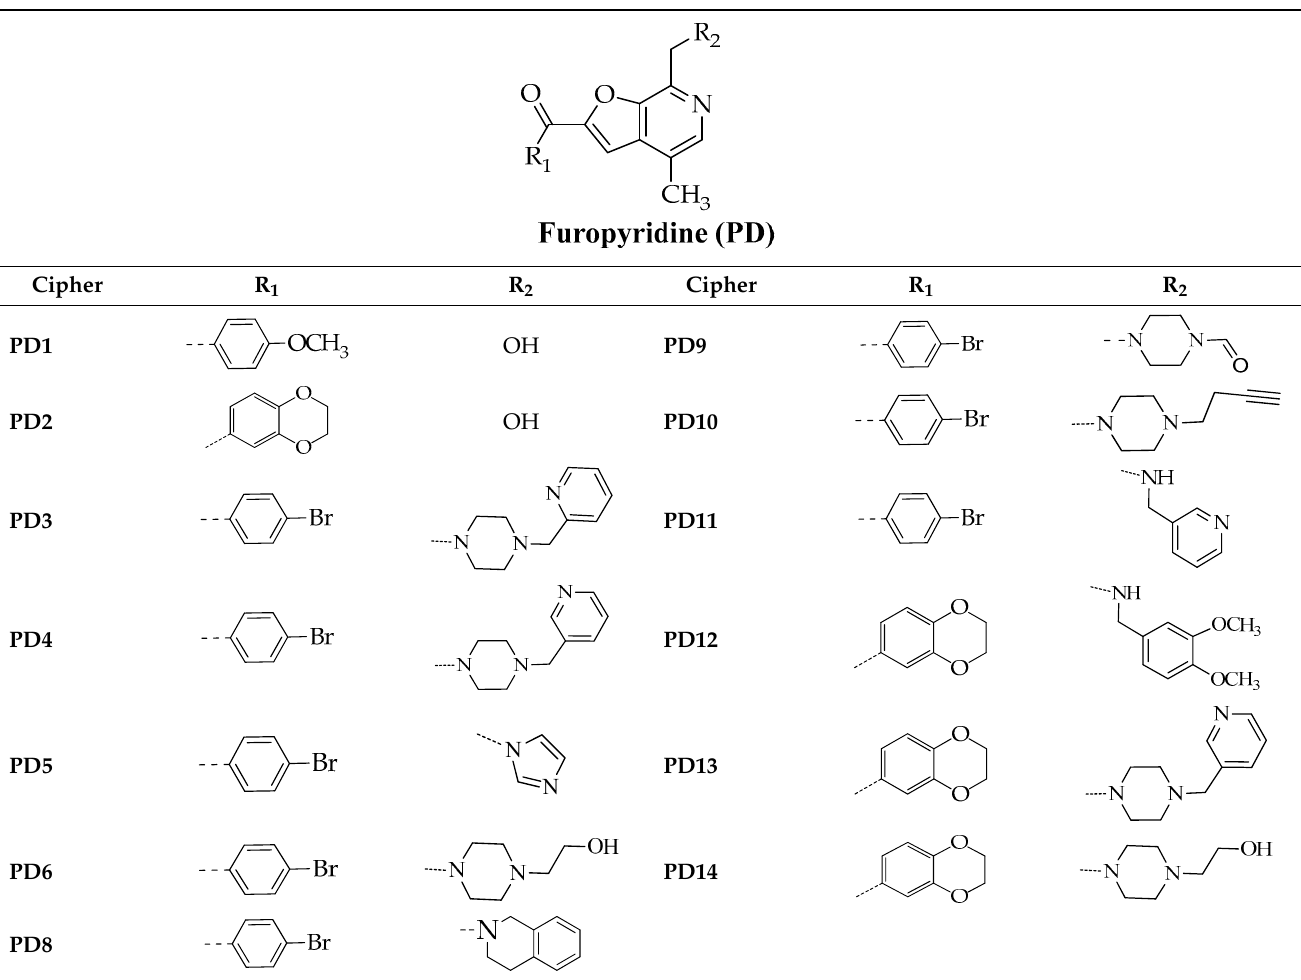
Table 1. Chemical structure of furopyridine; PD and its derivatives.